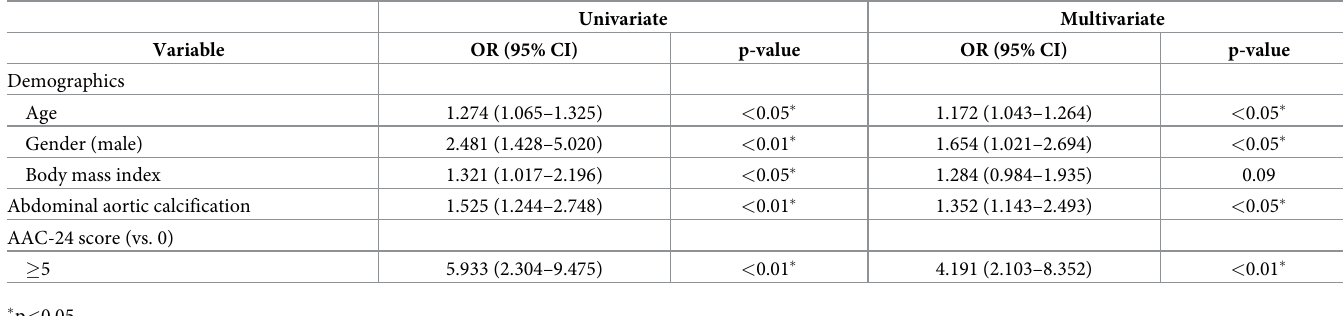
Table 5. Univariate and multivariate logistic regression analyses for carotid artery plaque.